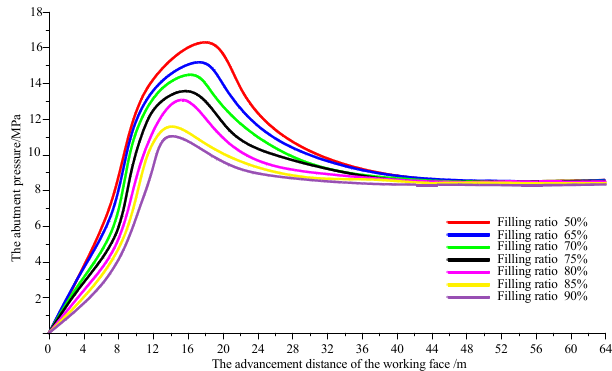
Figure 12. The abutment pressure distributions under different filling ratios with the advancement distance of the working face.